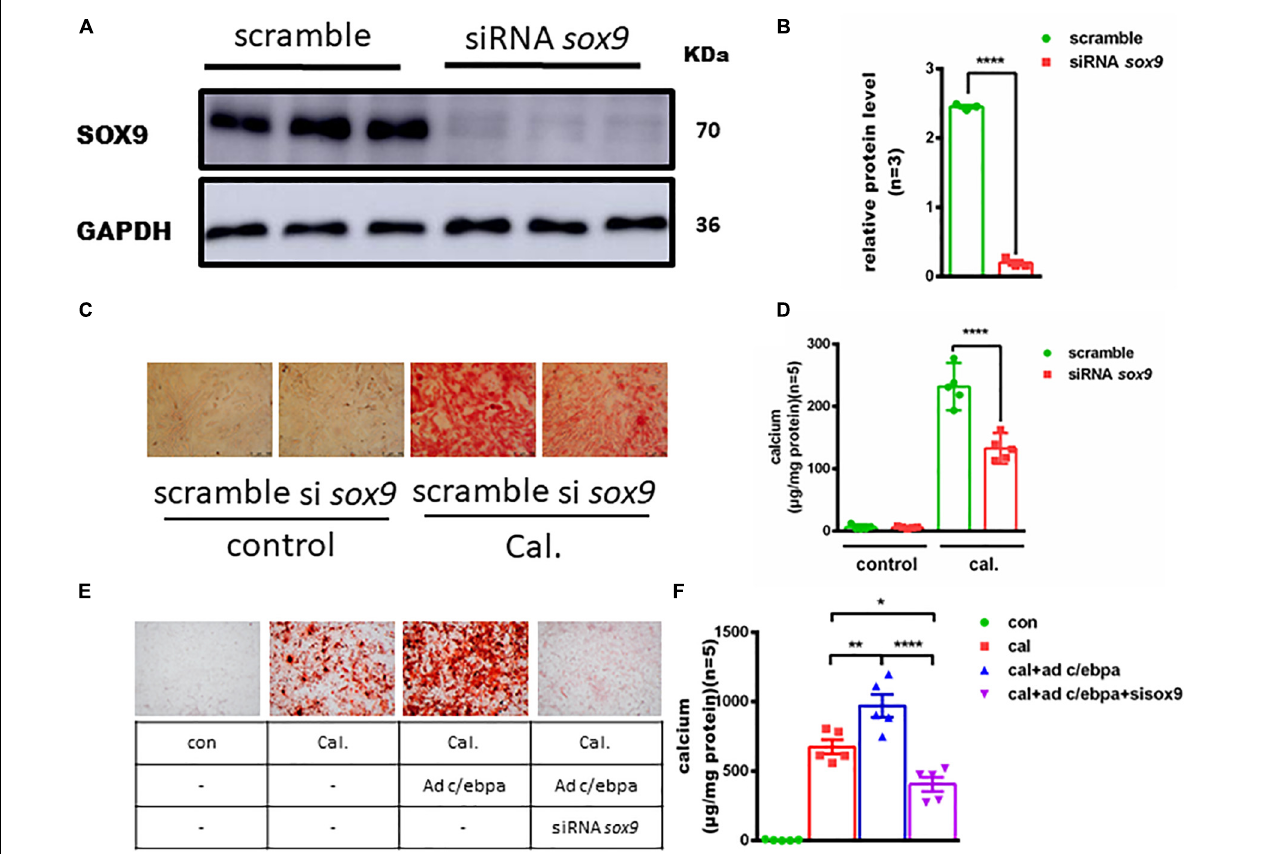
FIGURE 5 | Silencing of the Sox9 inhibits the calcium-/phosphate-induced vascular calcification. (A) Western blotting analysis of VSMCs vascular calcification for SOX9 proteins. (B) Semiquantitative analysis of Western blotting for SOX9 protein expression ( n = 3). (C) Representative images of alizarin red staining confirmed calcium deposition in VSMCs for the indicated experimental groups. Typical areas at 10 × magnifications are placed beside the respective panels. (D) Quantitative calcium assay for VSMCs for the indicated experimental groups ( n = 5). (E) Representative images of alizarin red staining confirmed calcium deposition decreased in VSMCs incubated with Ad-c/ebp α and siRNA sox9 in calcium/phosphate medium. Typical areas at 10 × magnifications are placed beside the respective panels. (F) Quantitative calcium assay for VSMCs for the indicated experimental groups ( n = 5). * p < 0.05, ** p < 0.01, **** p <